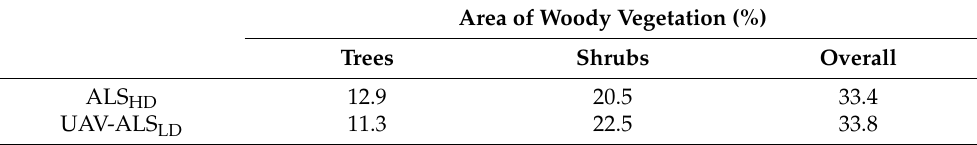
Table 7. The application of UAV-ALS LD nDSM for the estimation of vegetation structure character- istics compared to ALS HD as reference. The area of woody vegetation represents a percentage of vegetation cover (trees and shrubs). Woody plants of 1–5 m were classified as shrubs, and those above 5 m were classified as trees. Vegetation property calculations are presented in Tables 5 and 6. Area of Woody Vegetation (%) Trees